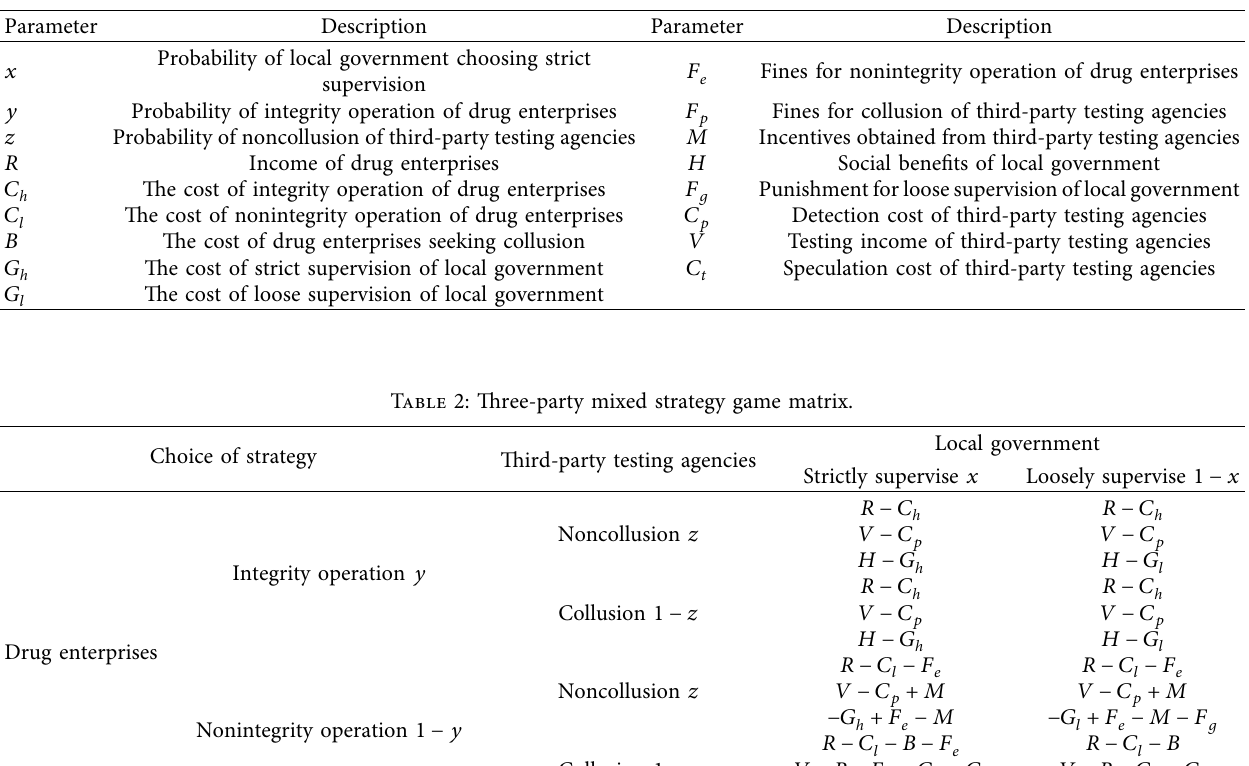
Figure 1: Three-party evolutionary game structure relationship. Table 1: Related parameter description.